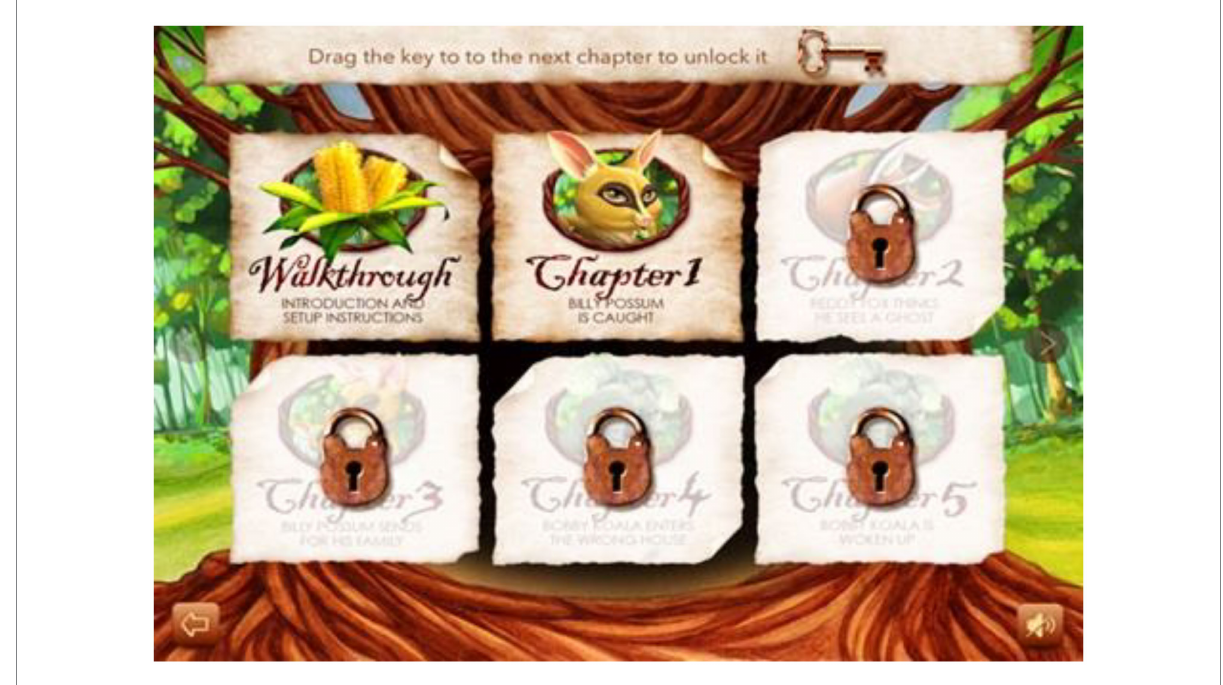
FIGURE 3 Screen shot of Chapter view in app showing Walkthrough and Chapter 1 completed.